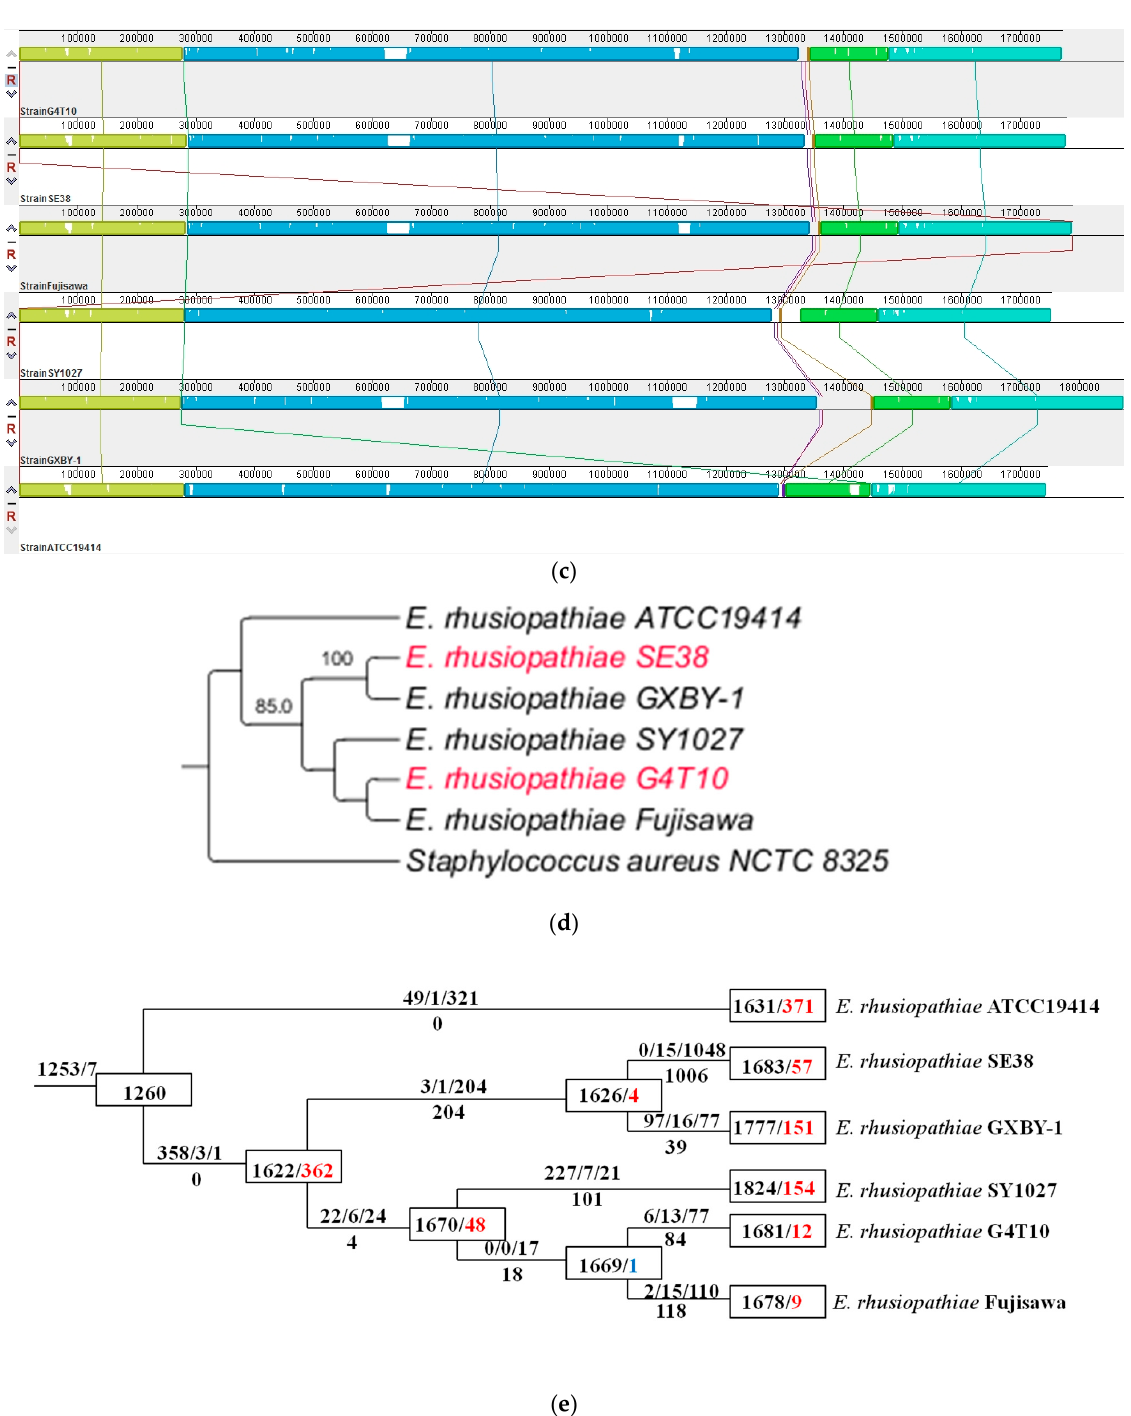
Figure 1. Pan-genome analyses of E. rhusiopathiae . ( a ) Flower plots showing the core gene number (in the center) and strain-specific gene number (in the petals) of the six E. rhusiopathiae strains. ( b ) Pan-genome and core genome curves of the six E. rhusiopathiae strains. ( c ) Mauve alignment of the six E. rhusiopathiae strains. ( d ) Phylogenetic tree of E. rhusiopathiae strains based on the 16S rRNA gene. ( e ) Phylogenetic tree of E. rhusiopathiae strains based on the concatenated alignment of single-copy core genes. The numbers in boxes on every node represent the genome size and the overall balance (gain–loss: balance), with black indicating the genome size, red indicating an overall gain, and blue indicating an overall loss. The numbers above and below every lineage show the number of birth/duplication/transfer and loss events.